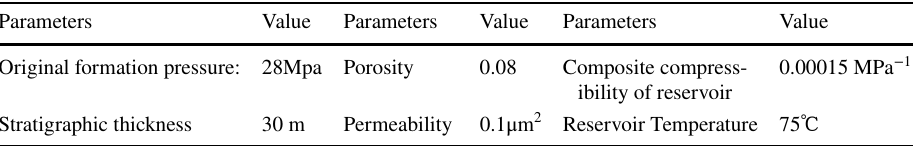
physical parameters